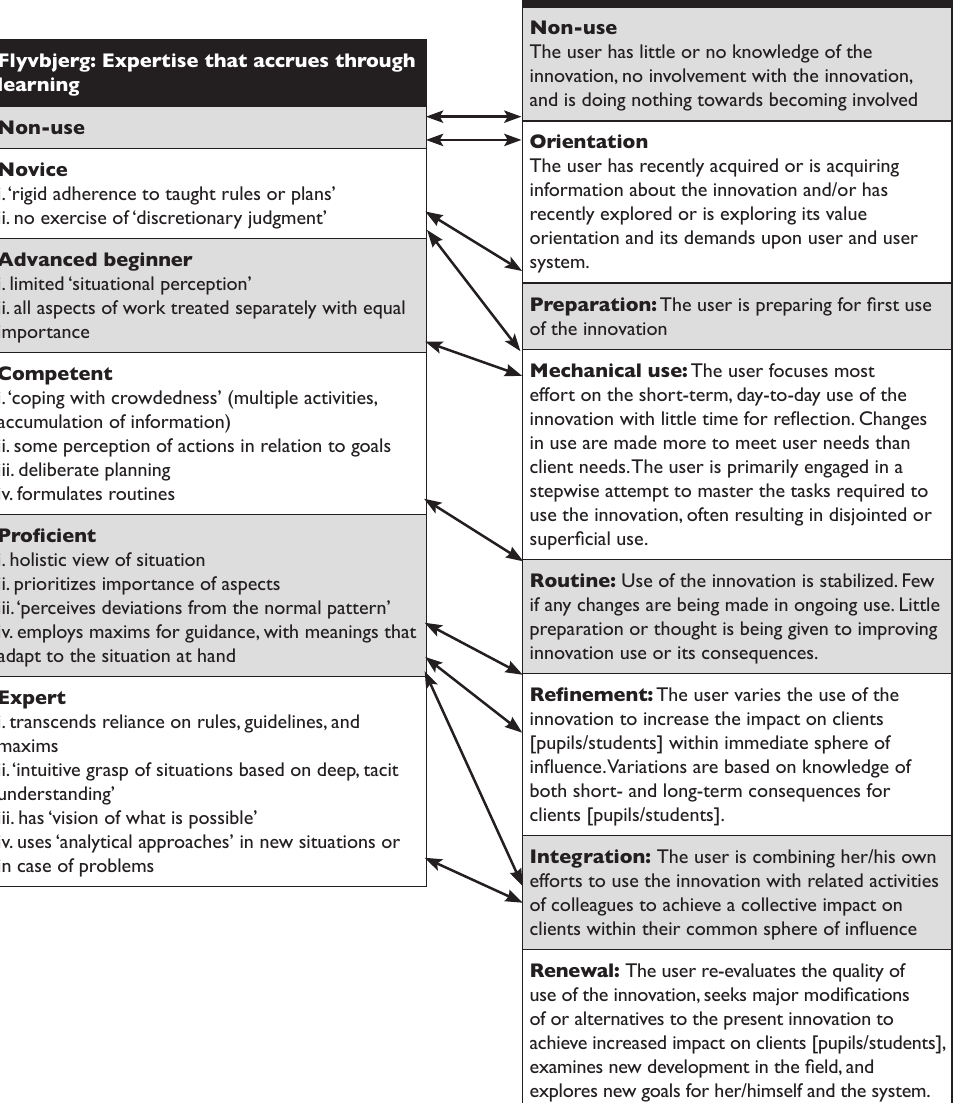
Flyvbjerg: Expertise that accrues through learning